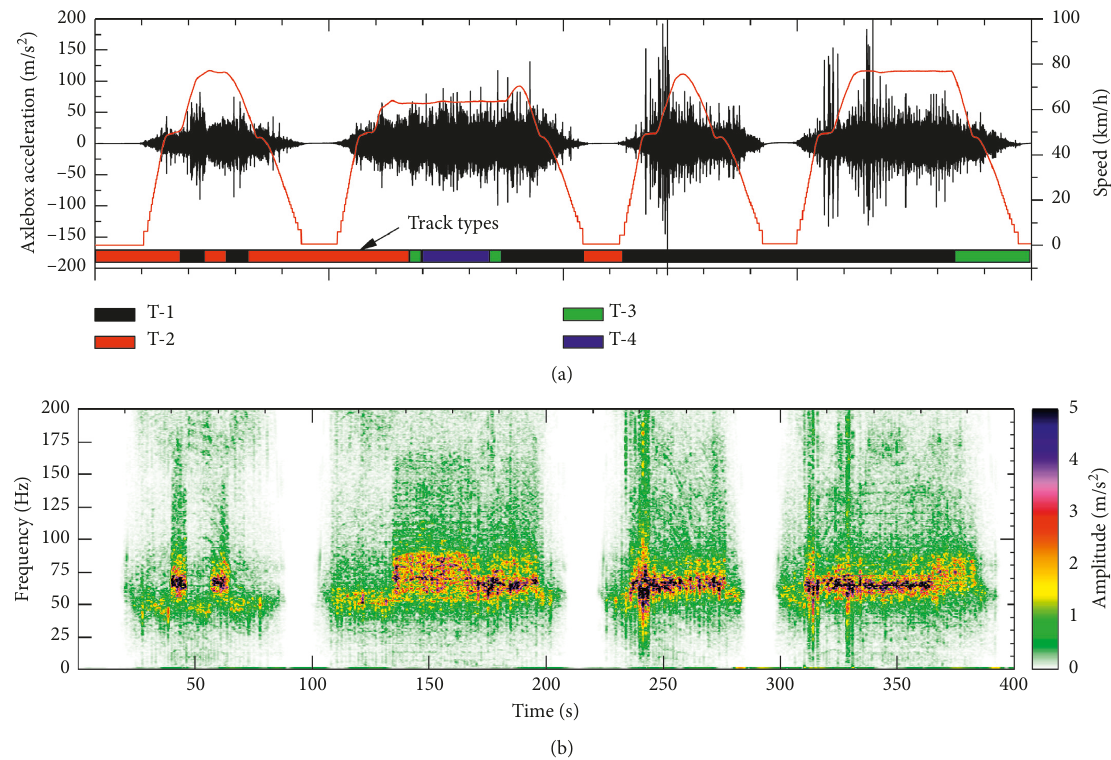
Figure 5: Measured vertical acceleration of the axlebox right after wheel reprofiling: (a) time-domain signal for a vehicle running on different types of track (T-1 for monolithic concrete bed with DTVI2 fasteners, T-2 for monolithic concrete bed with compression-type fasteners, T-3 for low-weight floating slab track, and T-4 for high-weight floating slab track); (b) time-frequency spectra of acceleration.